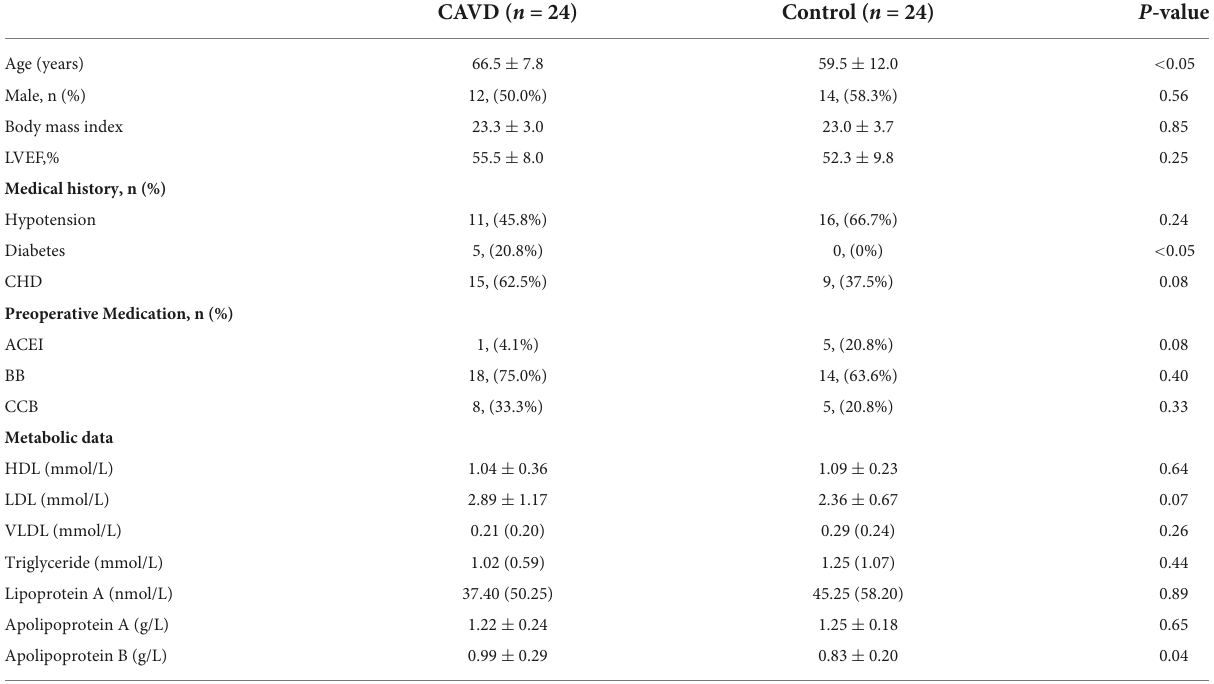
TABLE 1 Clinical characteristics of calcific aortic valve disease (CAVD) patients and control